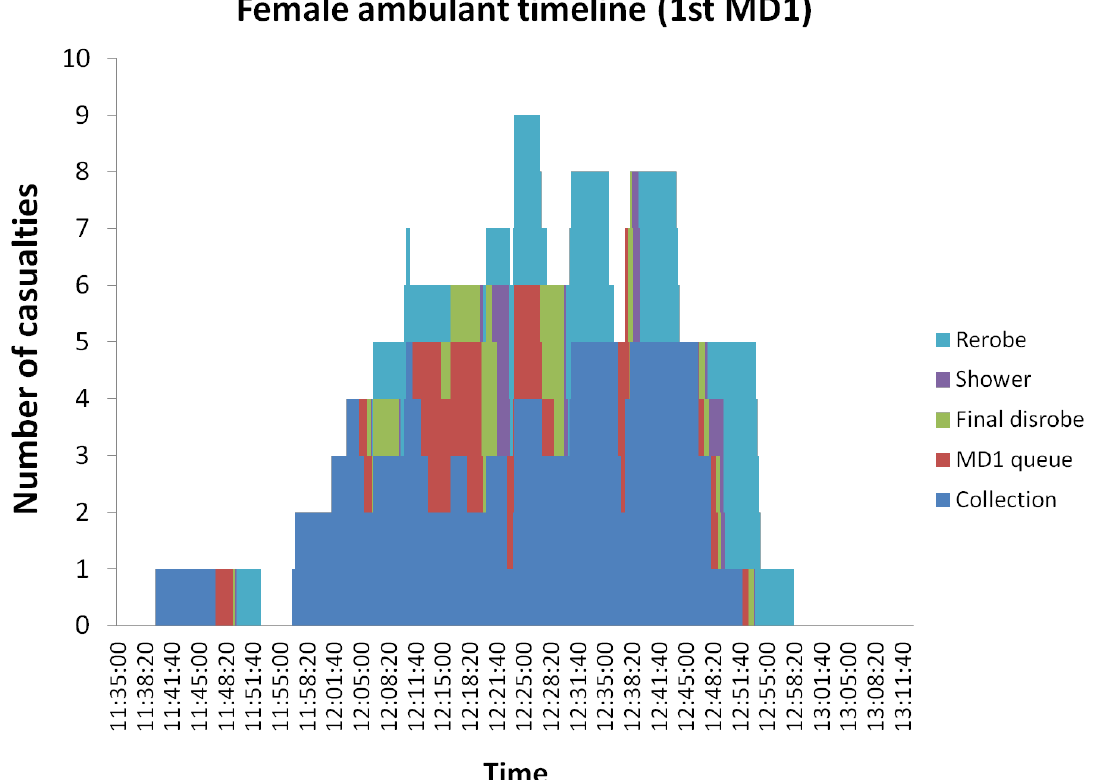
Figure A9. 18 female ambulant casualties passed through the casualty collection point where they performed their initial disrobe, and then waited in the MD1 queue before entering the final disrobe, shower and re-robe sections of the MD1. 10 different groups entered the MD1 giving an average group size of 1.8 (range = {1,3}). 10 casualties (56%) spent less than 30 seconds in the shower. The re-robe section was briefly at the intended capacity of 5 despite the shower section having at most 3 casualties at any one